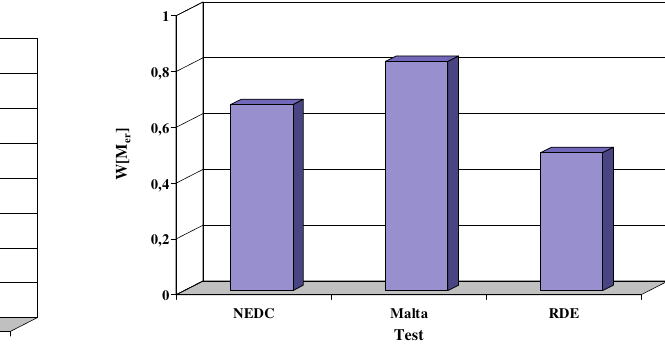
Fig. 9. A set of points in coordinates of engine rotational speed–relative torque in the RDE test